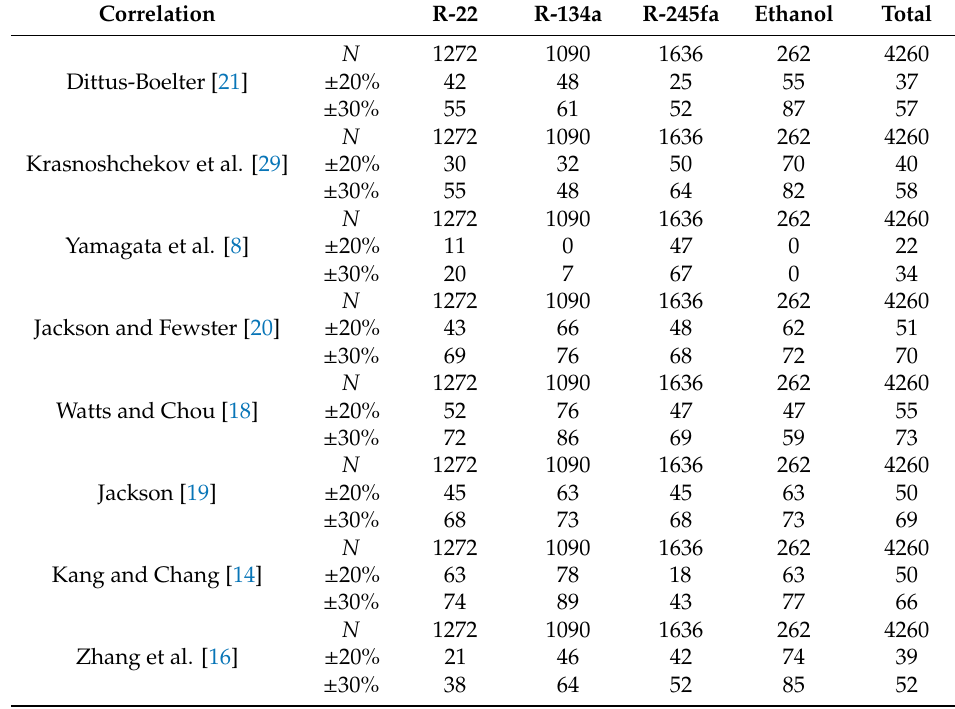
Table 8. Comparisons of the predictive ability of heat transfer coe ffi cient at supercritical states between the existing correlations and the test data for organic